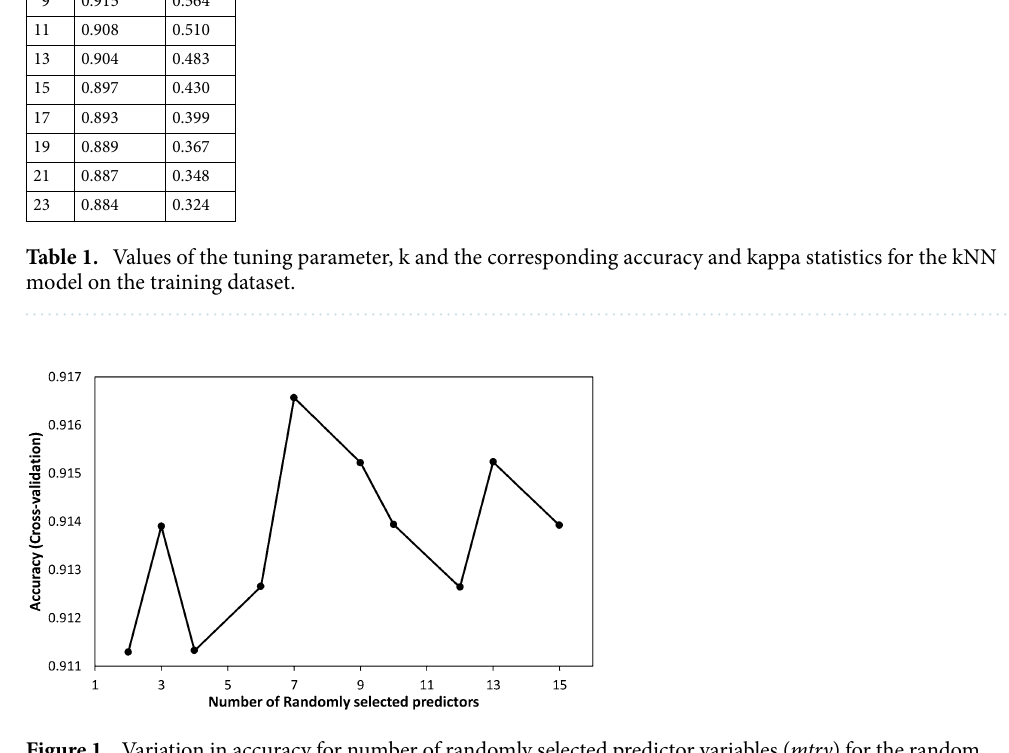
Figure 1. Variation in accuracy for number of randomly selected predictor variables ( mtry ) for the random forest classifier. Model accuracy is highest for mtry =